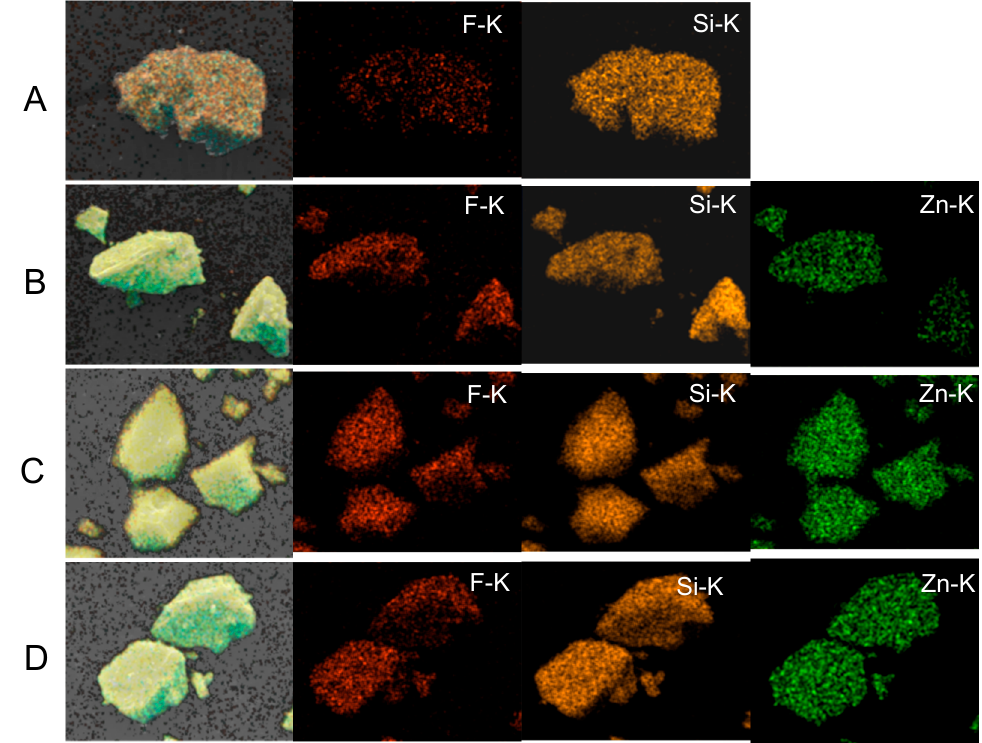
Figure 2. Elemental mapping images (EDS) of the four glass particles. ( A ) Cont, ( B ) PG-1, ( C ) PG-2, and ( D ) PG-3. Table 1. Elemental compositions of Cont, PG-1, PG-2, and PG-3 glasses (mol%) via XRF